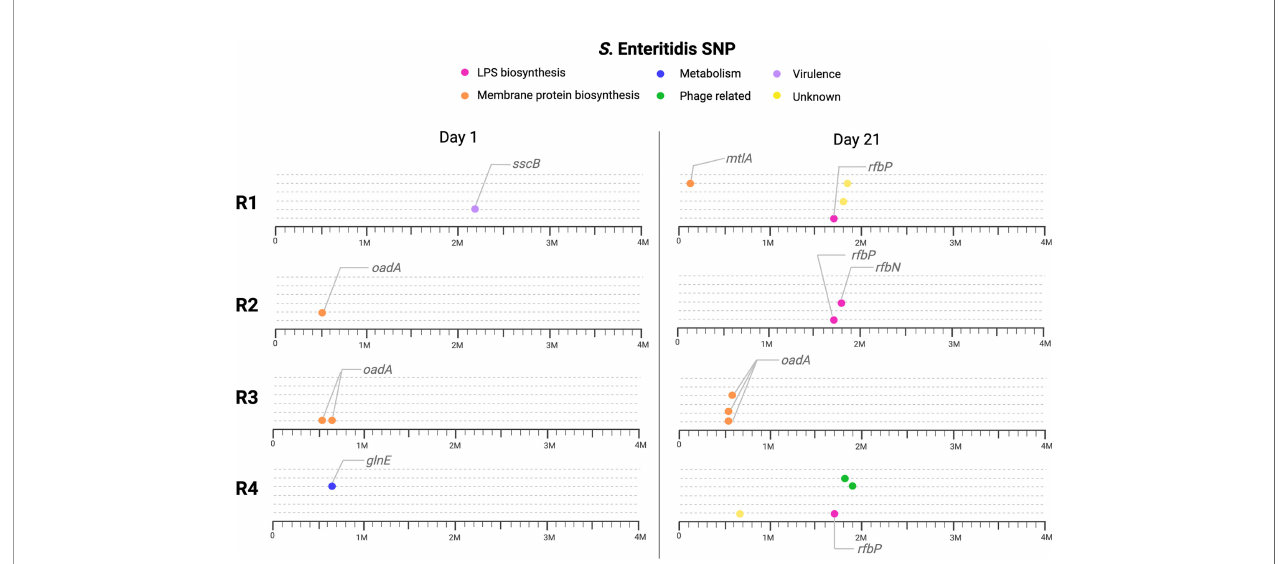
FIGURE 5 | SNP found in S . Enteritidis for day 1 (present) and day 21 (future) for the four replicates (R1, R2, R3 and R4). Genes indicated with lines are the most relevant, we also classi fi ed the genes with SNPs in six different categories. Pinks circles indicate genes associated with LPS biosynthesis, in orange membrane protein biosynthesis.